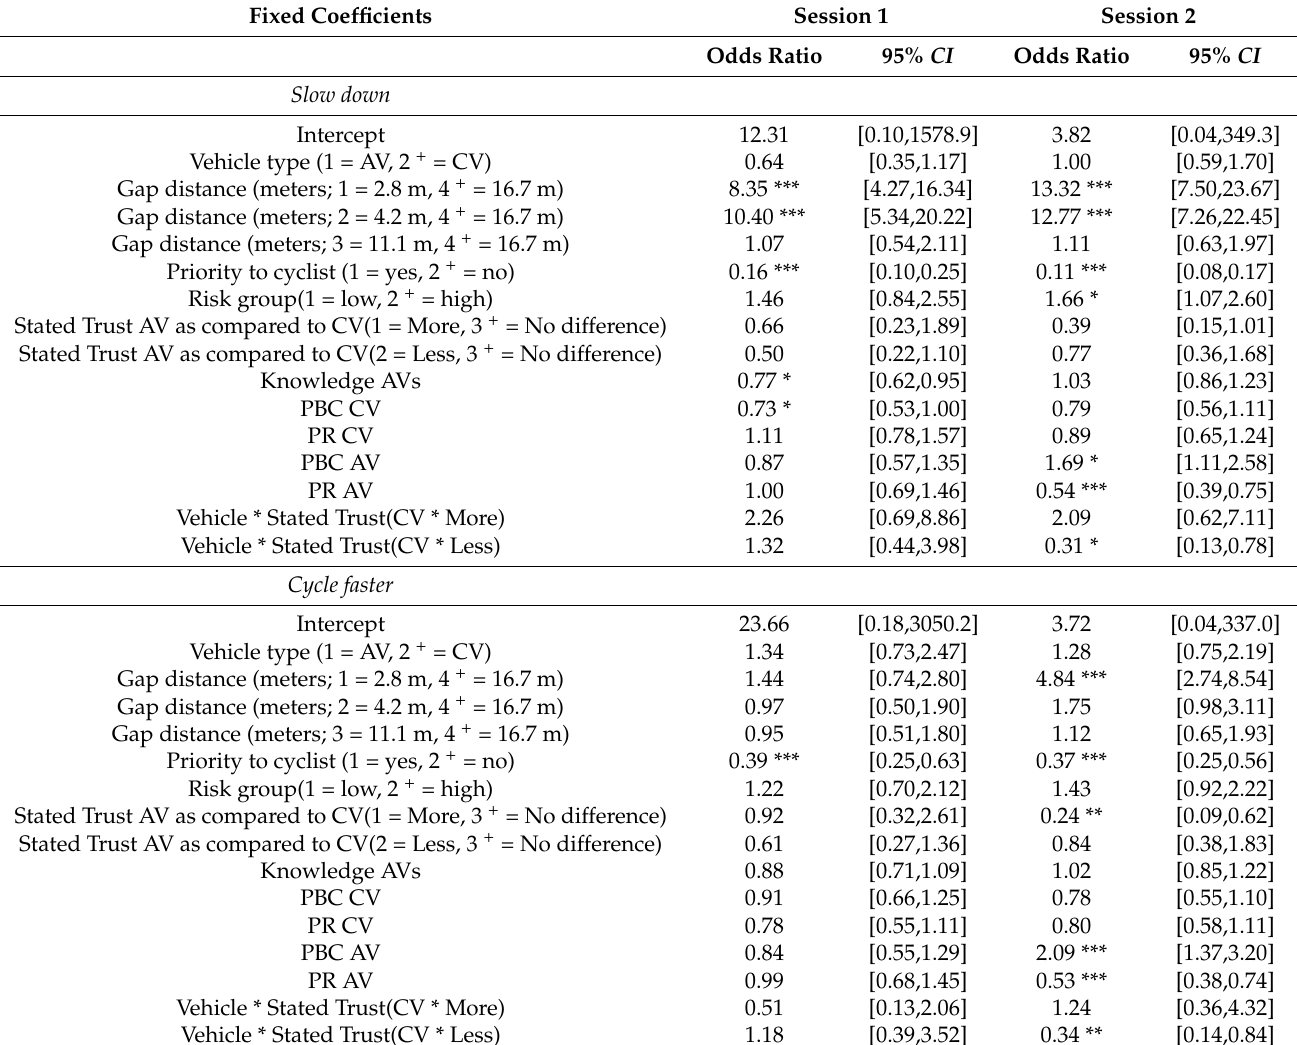
Table 5. Results of the crossing intentions MLMR model for both